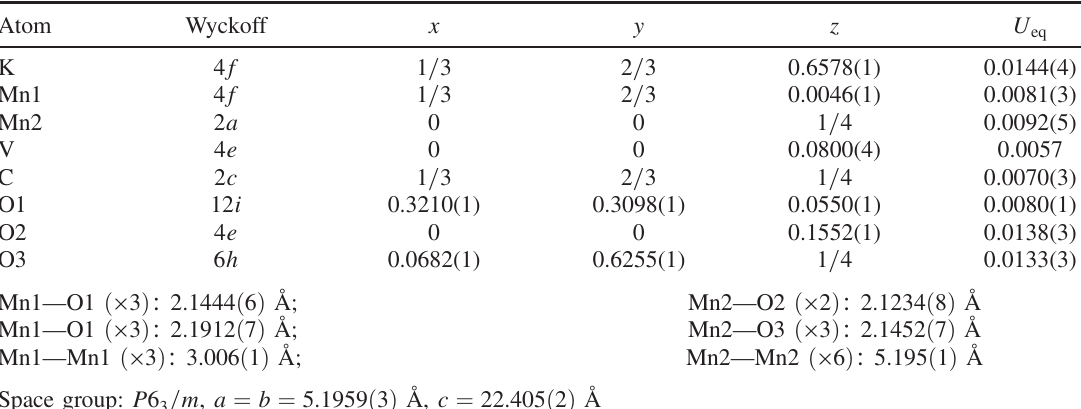
TABLE I. Refined structural parameters and selected bond distances of K 2 Mn 3 ð VO 4 Þ 2 CO 3 from single-crystal neutron-diffraction data collected at T ¼ 150